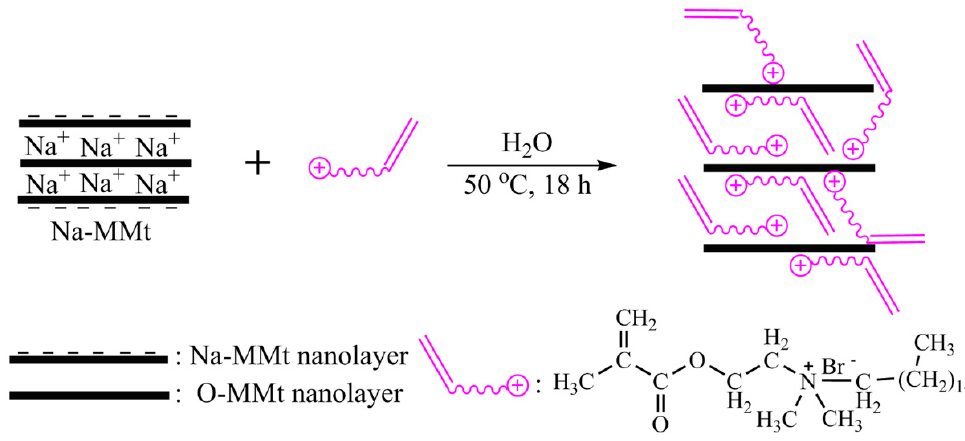
Figure 2. Preparation of the O-MMt intermediate.